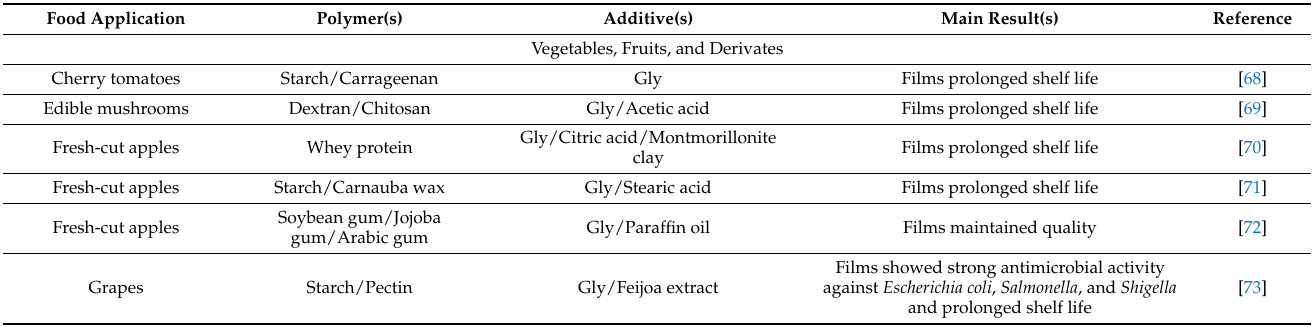
Table 1. Application of biodegradable films in food